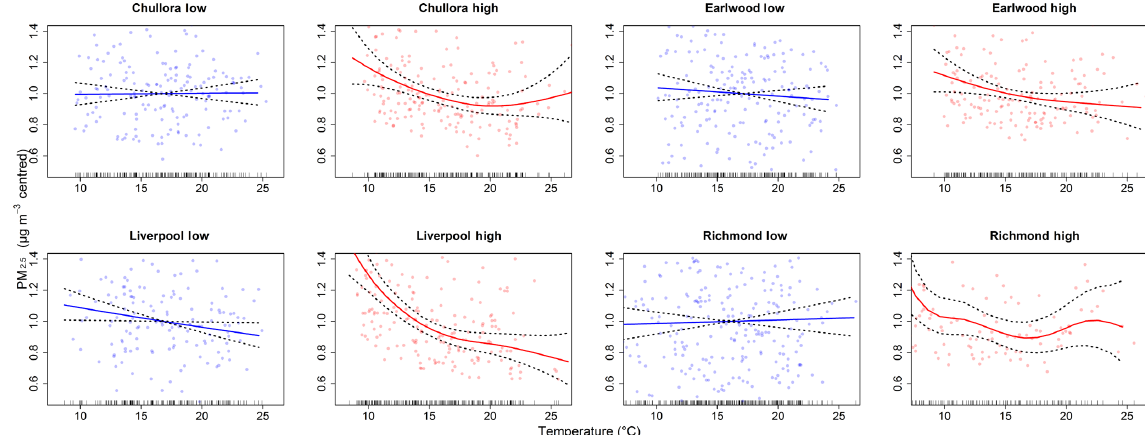
Figure 8. The contribution by the temperature component of the GAMM linear predictor to fitted PM 2 . 5 values (µgm − 3 , centred).